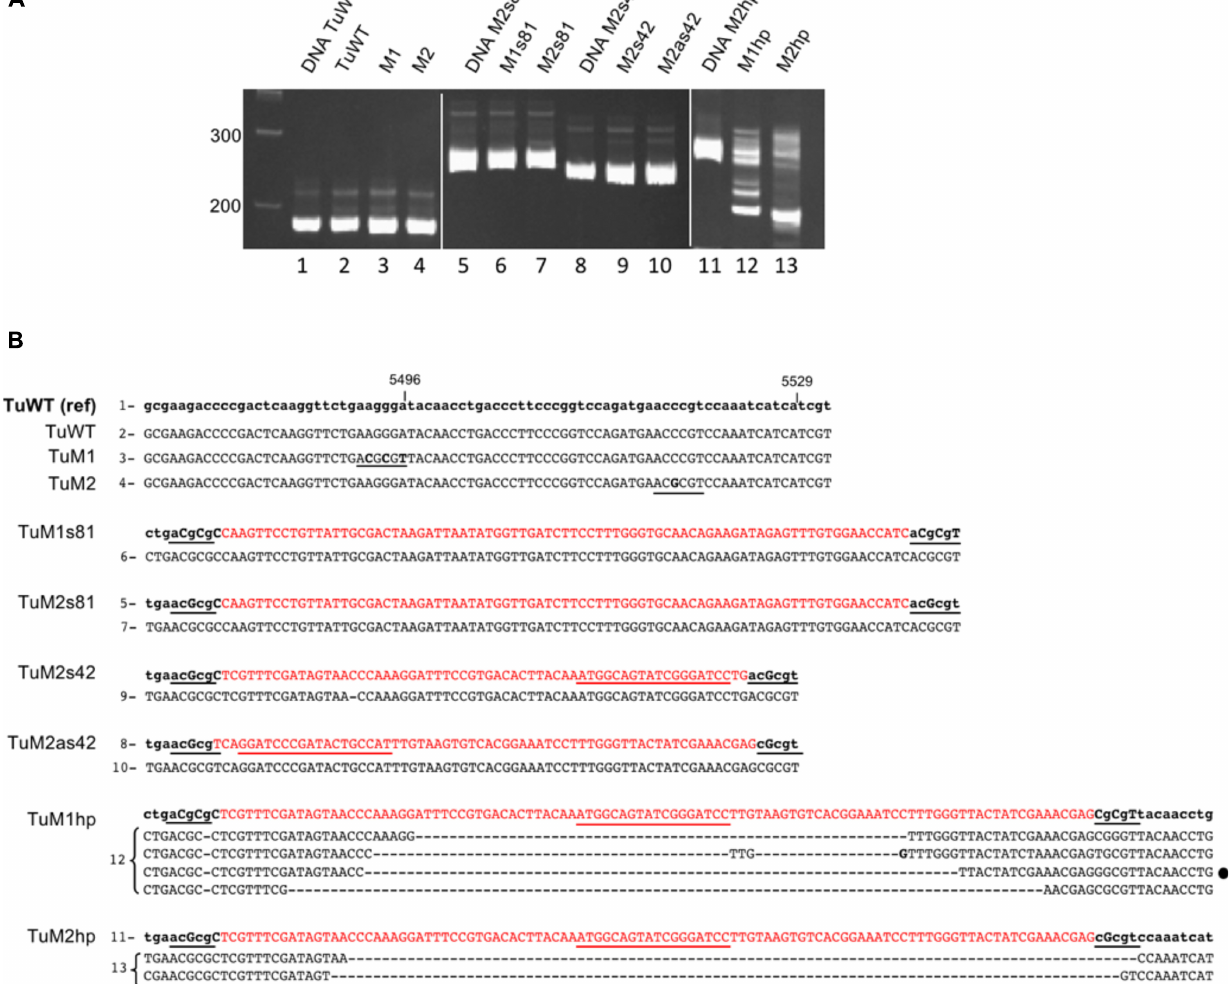
FIGURE 5 | Sequence analysis of recombinant TuYV offspring by RT-PCR. (A) Analysis on a 6% polyacrylamide gel of the PCR fragments obtained after reverse transcription performed on RNA extracted 19 dpi from plants agroinfected with TuWT (2) or the different mutants TuM1 (3), TuM2 (4), TuM1s81 (6), TuM2s81 (7), TuM2s42 (9) or TuM2as42 (10), TuM1hp (12), and TuM2hp (13). PCR size controls were produced from the corresponding plasmid DNA (lanes 1, 5, 8, and 11). The first lane at the left represents the size markers in base pairs. (B) Sequence analysis of the above described PCR fragments. The reference sequence of each virus (name on the left) is in the upper lane with modified nucleotides in capital letters and the inserted CHLI1 sequence in red. The numbers at the left of the sequences (1–13) refer to the lanes of the gels shown in panel A . The sequence in lower case corresponds to the original viral sequence. The inserted Mlu I sites and the Mlu I compatible cohesive ends are underlined in black and the nucleotide mutations introduced in the viral genome are in capital letters. The sequences obtained for the offspring of each recombinant virus are shown in capital letters below the reference sequences. For the hp clones, several bands were cut out from the gel and the resulting sequences are indicated. The loop sequence is underlined in red. For TuWT, TuM1 and TuM2 only the progeny sequences were shown as they were identical to their reference sequences. The mismatches with the reference sequence are in bold; (–) means a nucleotide deletion. The black dot at the right side of one TuM1hp sequences represents a particular sequence that was also found in the TuM1hp progeny after aphid transmission (see Supplementary Figure S5